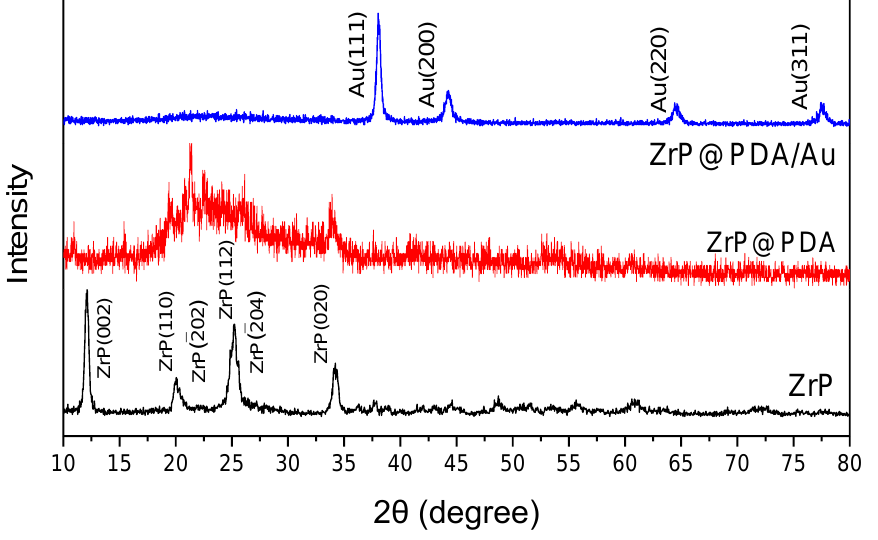
Figure 4. XRD patterns of the ZrP, ZrP@PDA, and ZrP@PDA/Au samples. FTIR spectra were further employed to clarify the surface functionalities on the typical ZrP, ZrP@PDA, and ZrP@PDA/Au samples (see Figure 5). The typical FTIR